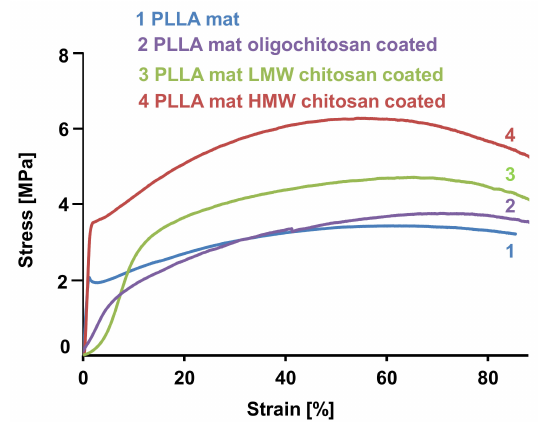
Figure 4. Stress–strain curves of: 1. A PLLA mat; 2. A PLLA mat coated with oligochitosan; 3. A PLLA mat coated with LMW chitosan; and 4. A PLLA mat coated with HMW